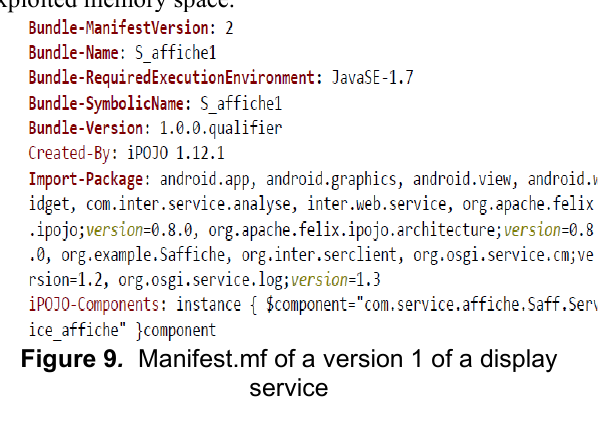
Figure 9 . Manifest.mf of a version 1 of a display